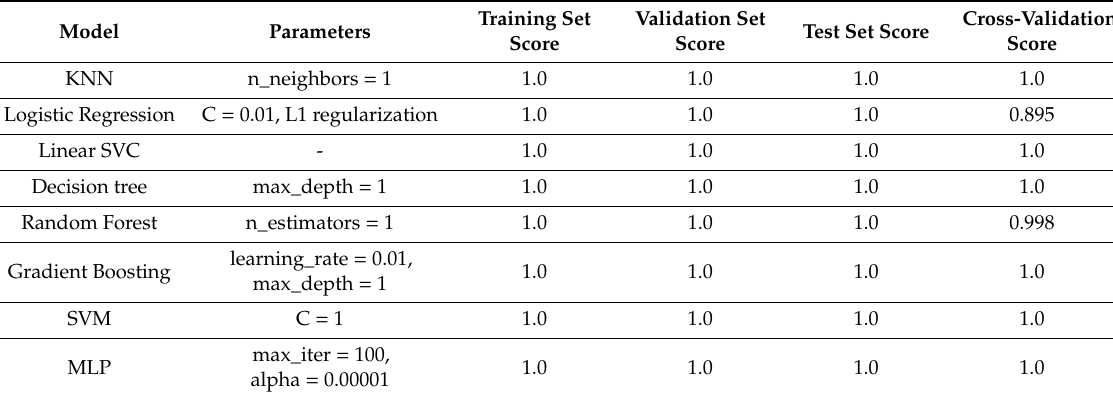
Table 6. Experiment results of training set, validation set, and test set scores using Dataset 1 with elapsed time and flag.